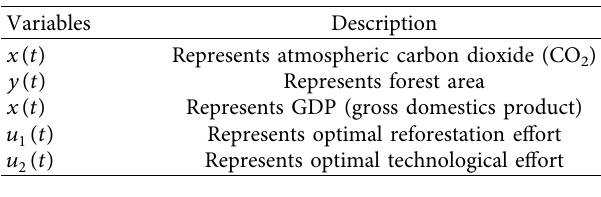
Table 1: Description of variables and control